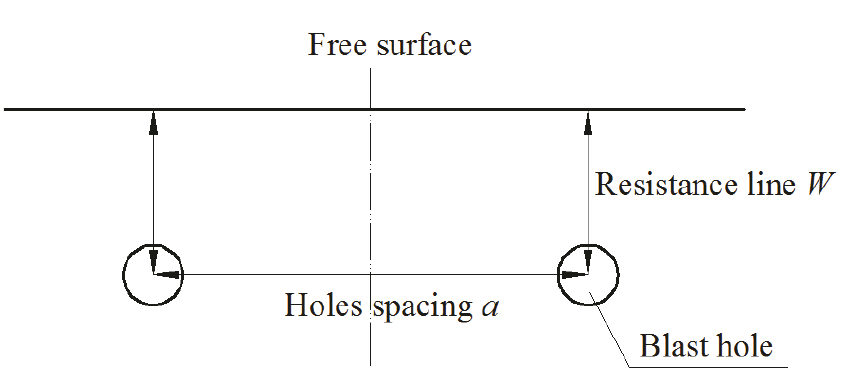
Figure 11: Blast hole layout.